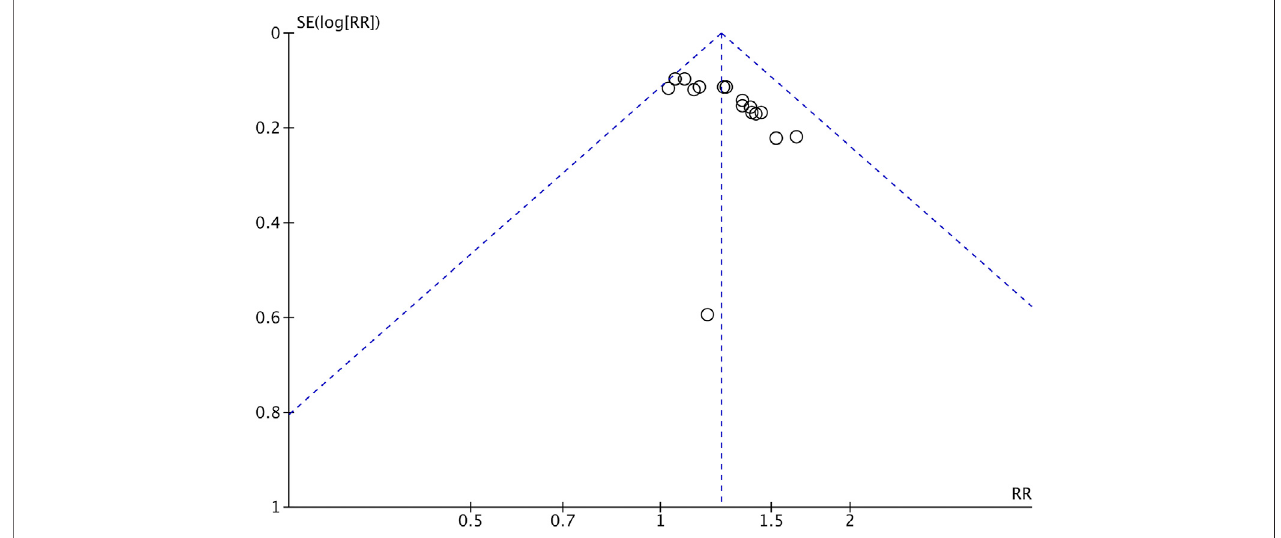
FIGURE 9 | Funnel plot of tumor response (CR + PR) of Astragalus-containing CHM combined with CT vs. CT alone. CHM, Chinese herbal medicine; CT, chemotherapy; CR, complete response; PR, partial response.